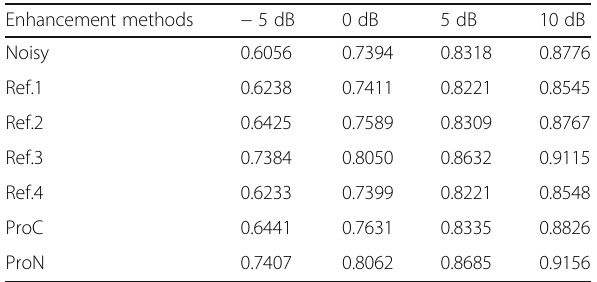
Table 4 Comparison on average STOI Enhancement